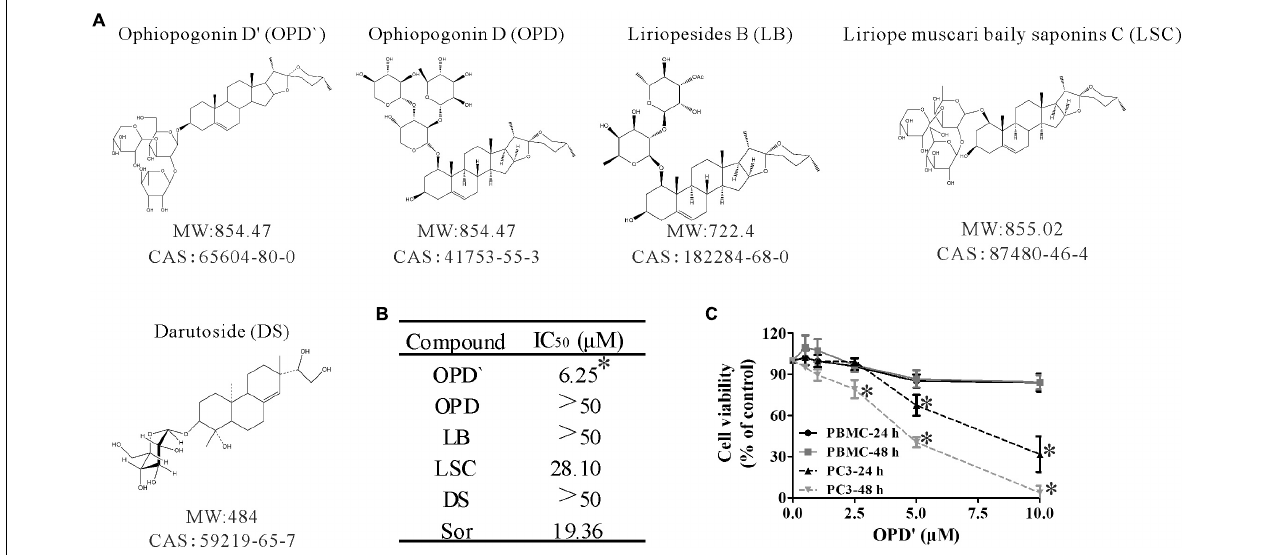
FIGURE 1 | The chemical structures and anticancer activity of five compounds. (A) The chemical structures of the compounds. (B) The concentrations of the five compounds and one positive control (Sorafenib) that induced 50% growth inhibition (IC 50 ) in PC3 cells after 24 h of exposure. n = 3 independent experiments. ∗ p < 0.05 vs. OPD, LSC, LB, or DS. (C) After being treated with various concentrations of OPD (cid:48) for 24 or 48 h, the viability of PBMC or PC3 cells was checked using the CCK-8 assay. PBMC were isolated from whole blood obtained from seven healthy donors. n = 3 independent experiments. ∗ p < 0.05 vs. 0 µ M OPD (cid:48)